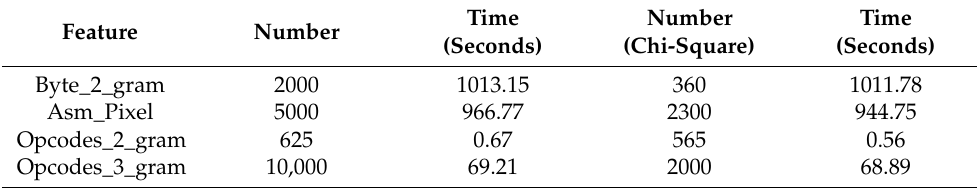
Table 4. Chi-square veri fi cation for feature selection.